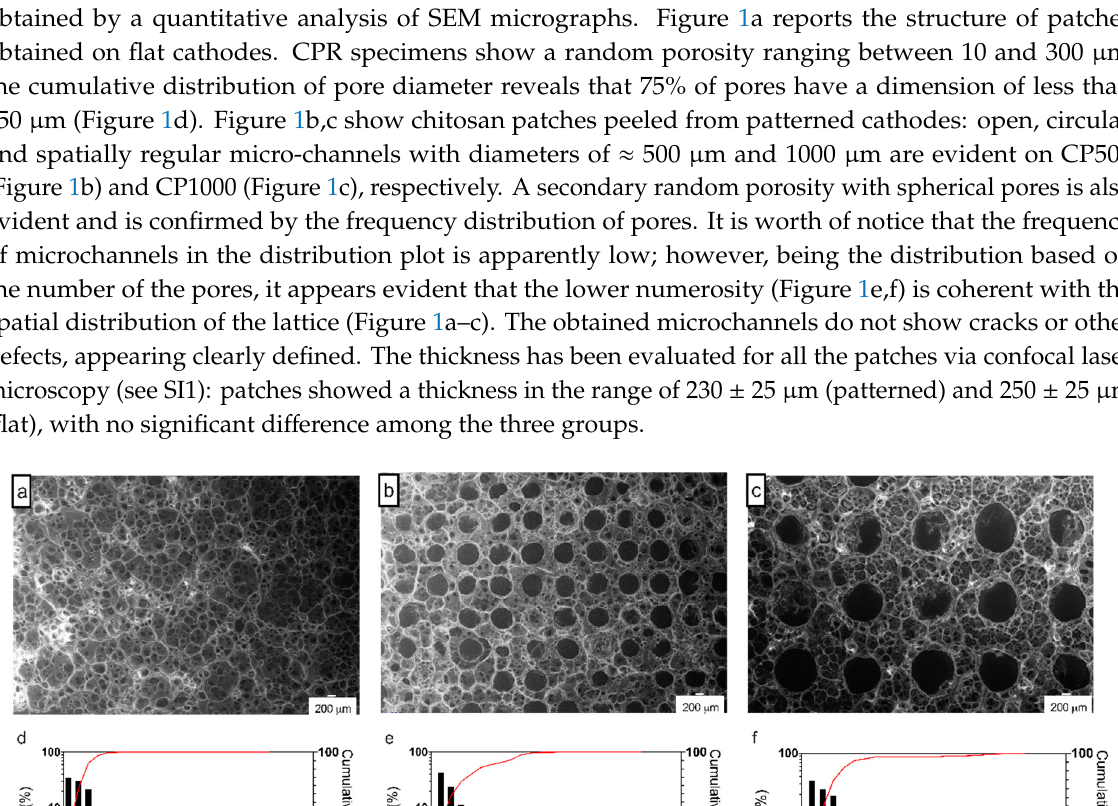
Figure 2. Uniaxial tensile tests on flat and micro-patterned patches in wet conditions: ( a ) representative preconditiong cycle for CPR specimens, ( b ) tensile tests up to break, and ( c ) Young modulus (E).